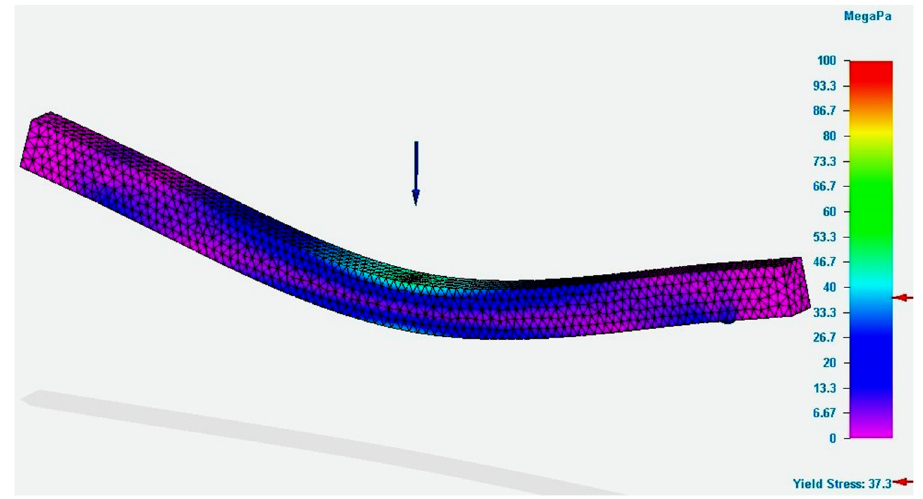
Figure 3. Results of the simulation process for P_R12 specimen (Von Mises stress).